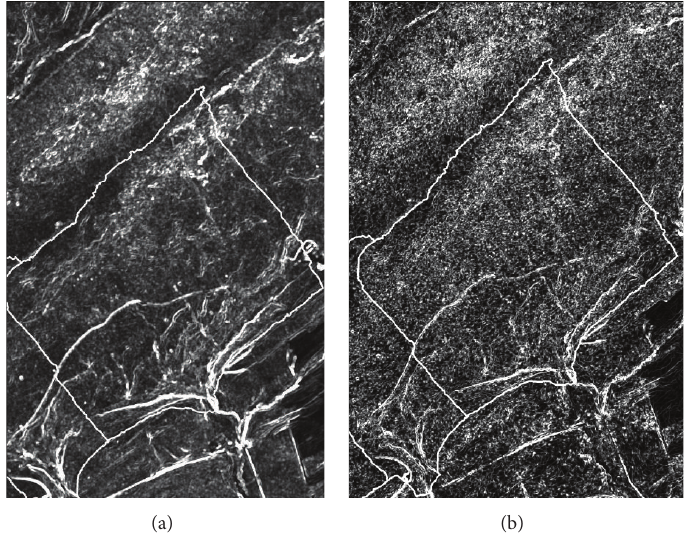
Figure 9: Standard deviation of slope for CZO LiDAR (a) and PAMAP LiDAR (b). White areas correspond to high roughness